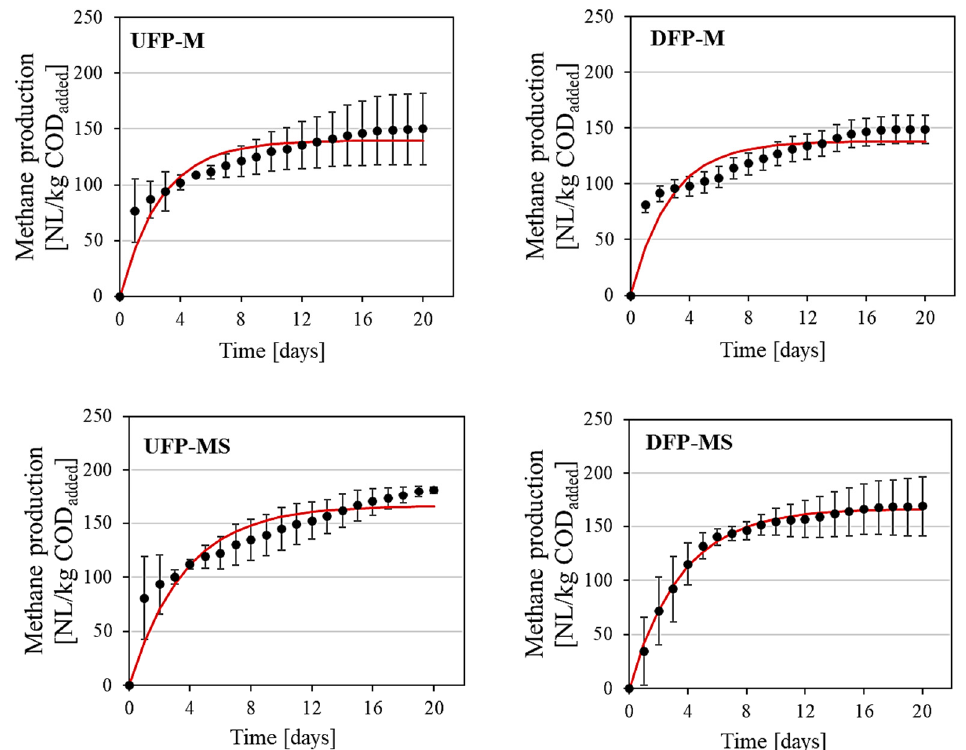
Figure 3. Comparison between measured data (points) and data calculated with the first order regression (red line) for specific methane production from ultrafiltration permeates in the 20-day test: UFP-M = milk ultrafiltration permeate; DFP-M = milk diafiltration permeate; UFP-MS = milk serum ultrafiltration permeate; DFP-MS = milk serum diafiltration permeate. The gas from the inoculum has been subtracted and the data have been expressed as volume of CH 4 per kg of COD added .